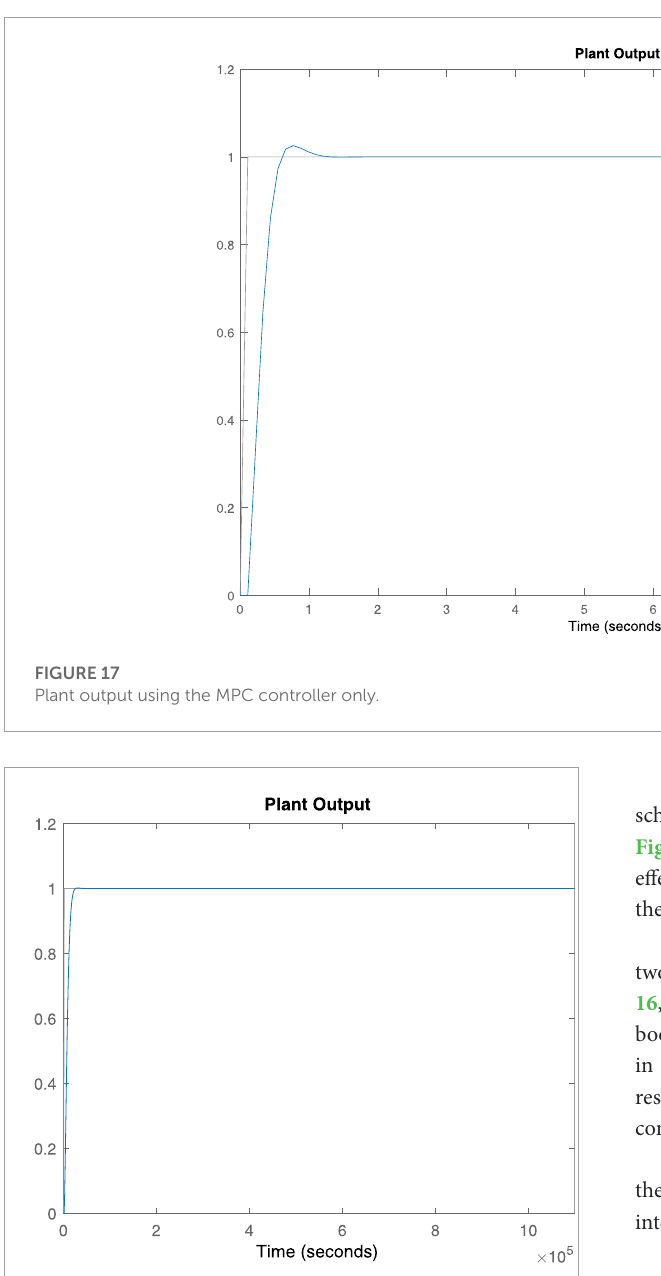
FIGURE 18 Interleaved plant output using the MPC controller